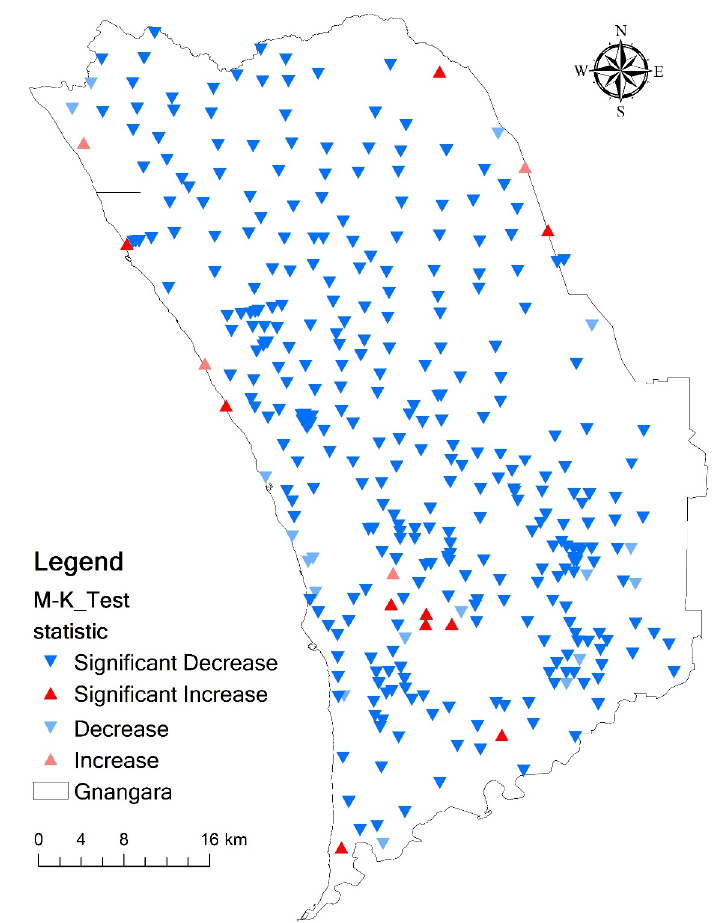
Figure 8. Trend of groundwater level at 351 bore sites.